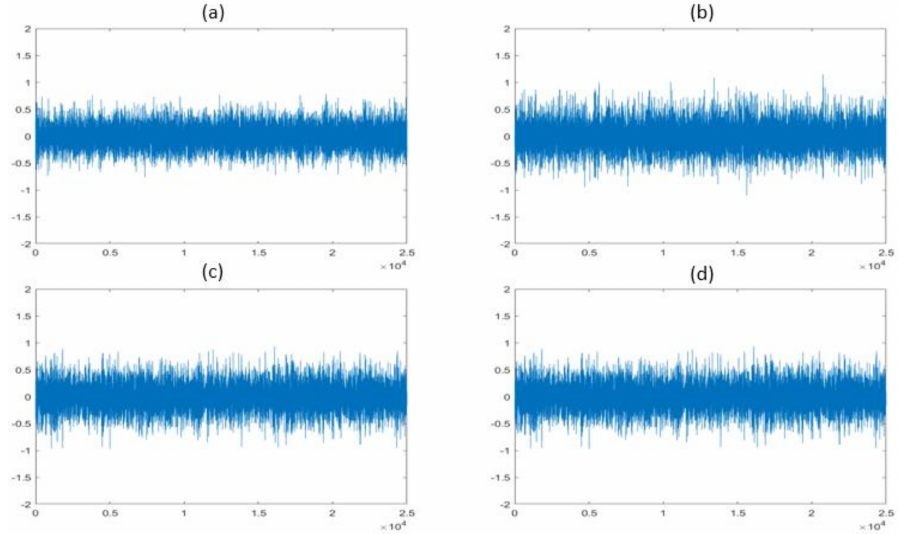
Figure 7. Time-domain vibration sequences in ( a ) normal, ( b ) impeller fault, ( c ) MSH fault, and ( d ) MSS fault conditions.